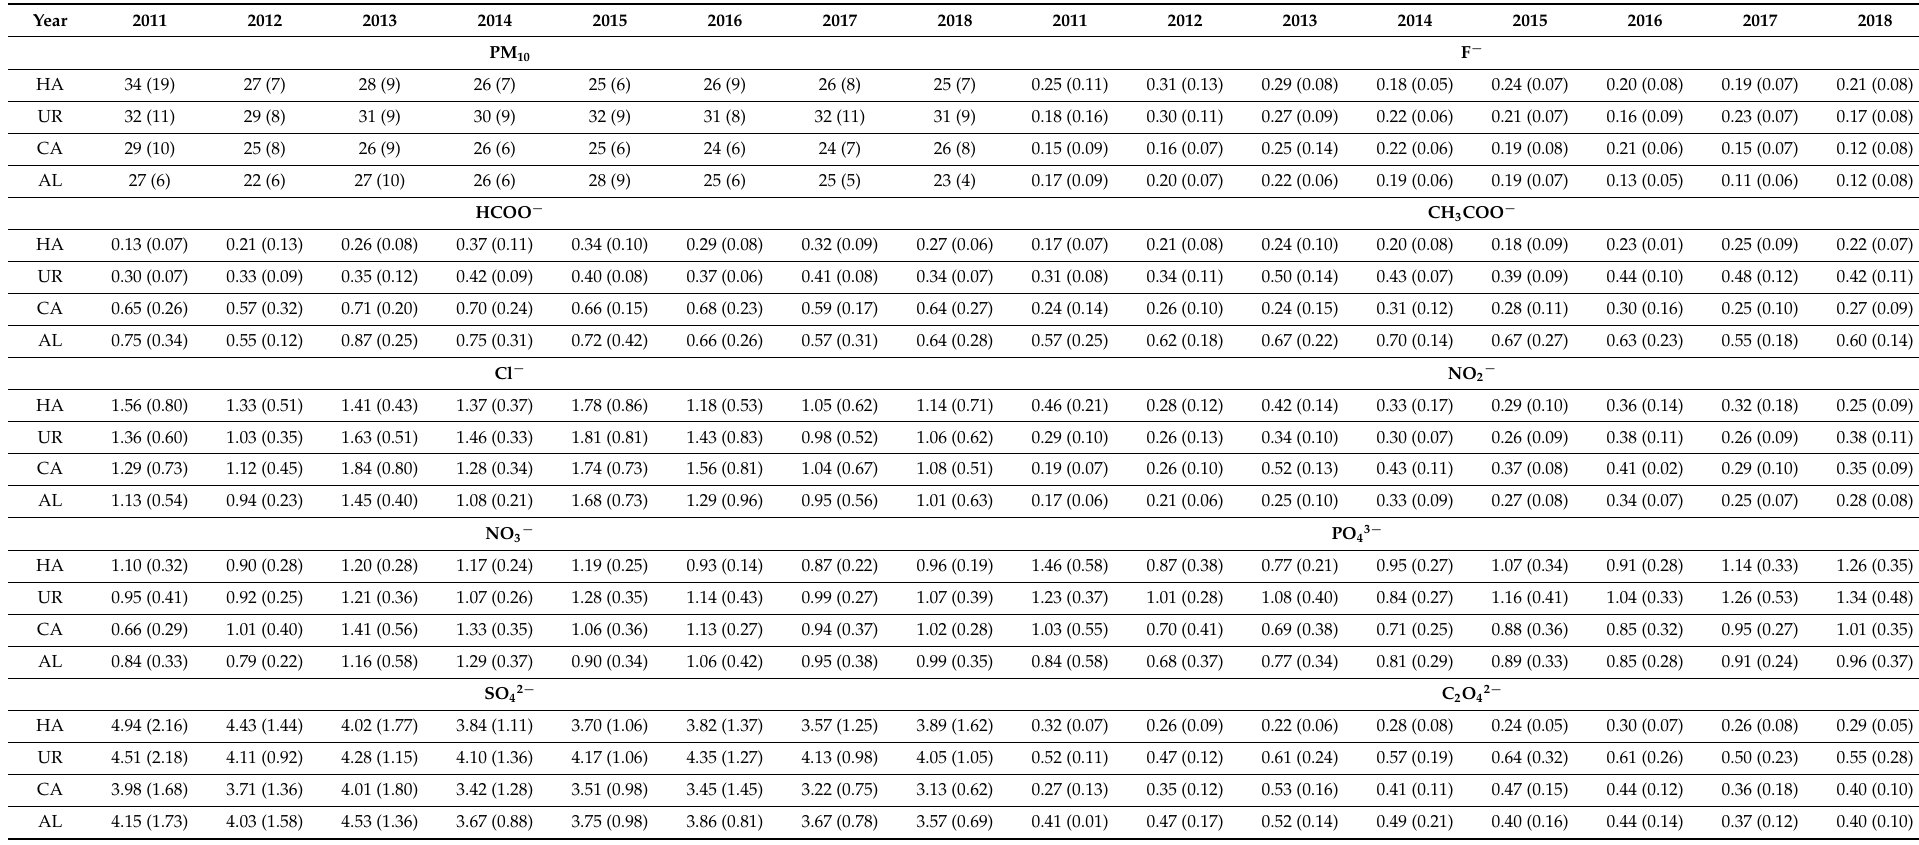
Table 4. Annual average concentrations of PM 10 and water-soluble ions ( µ gm − 3 ) and their standard deviations for the 4 sampling sites,